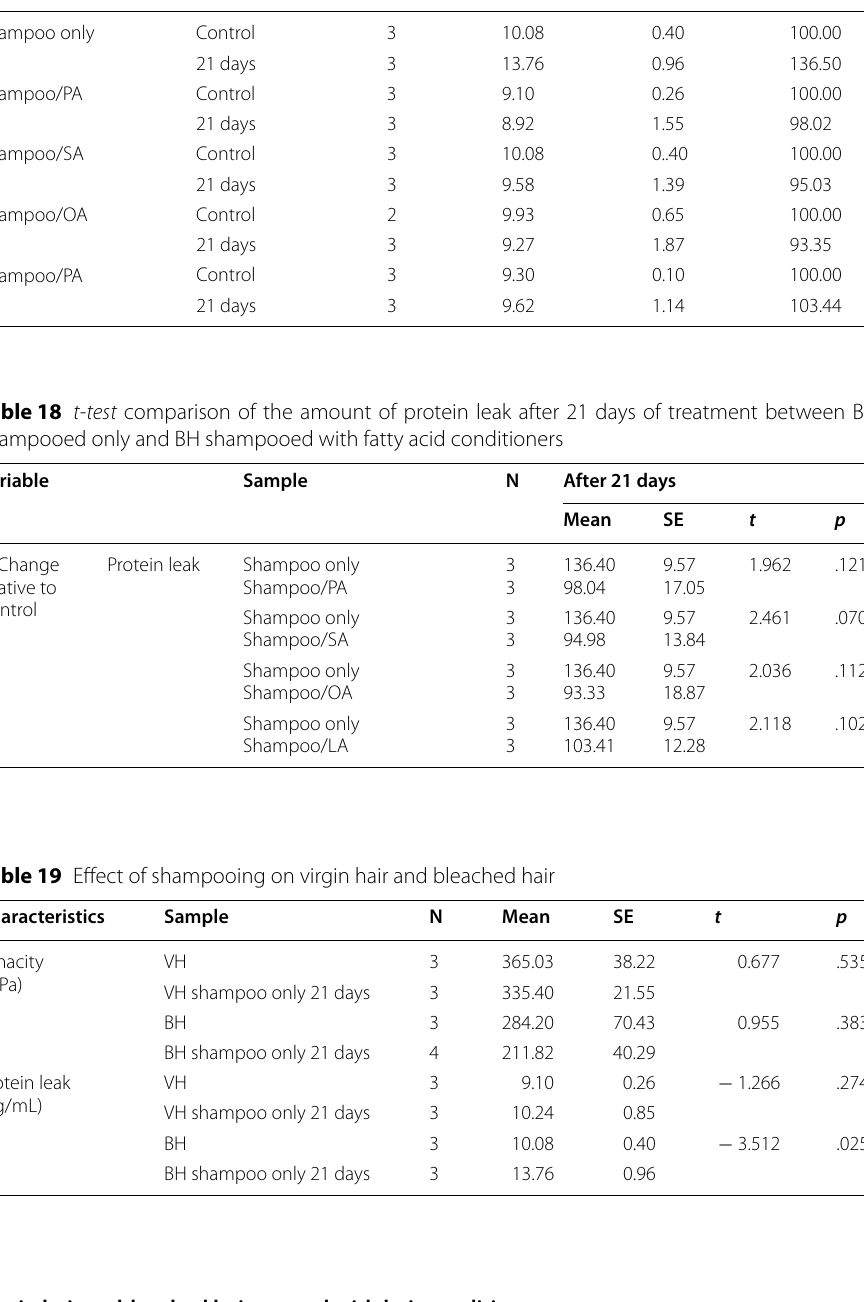
Table 17 Amount of protein leaking from bleached hair shampooed with or without the use of hair conditioner containing four types of fatty acids Sample